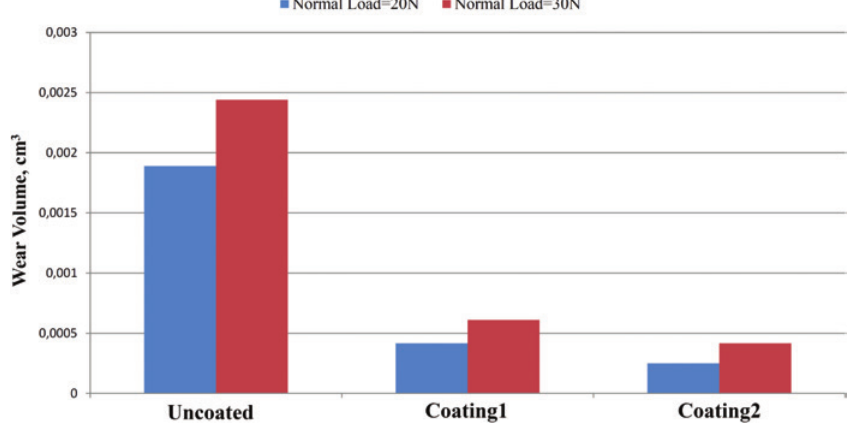
Fig. 6: The wear volumes of uncoated and coated